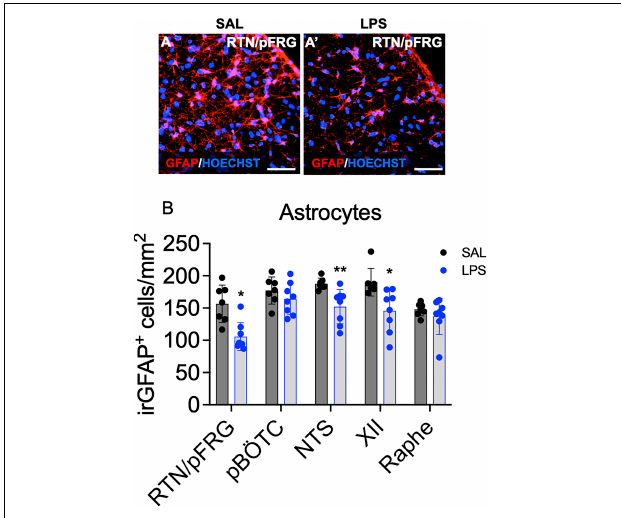
FIGURE 7 | IBA-1 + microglia within brainstem respiratory centers. Representative images of microglial phenotypes assessed (A) . Total numbers of IBA-1 + microglia and numbers of ramified, hyper ramified, reactive, and ameboid IBA-1 + microglia in the RTN/pFRG (B) , preBÖTC (C) , XII (D) , NTS (E) , and raphe nucleus (F) in SAL (control = black, n = 8) and LPS-exposed fetuses (blue, n = 8). Data are means ± SD, * P < 0.05 vs. control.